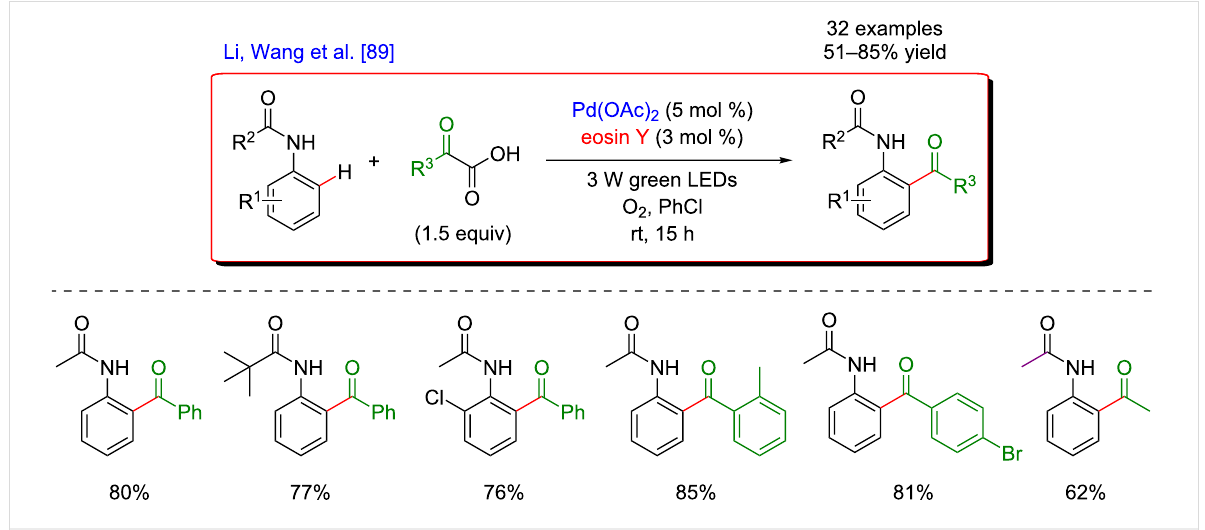
Figure 27: Acetanilide derivatives acylation via the dual C–H activation/photoredox catalysis.